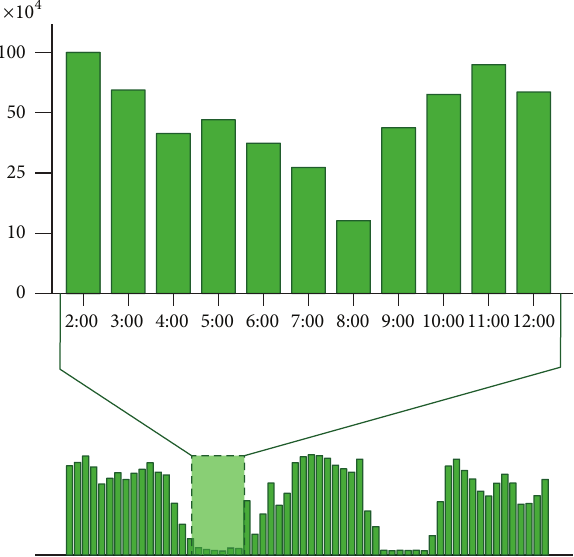
Figure 4: Detailed information from overview map.